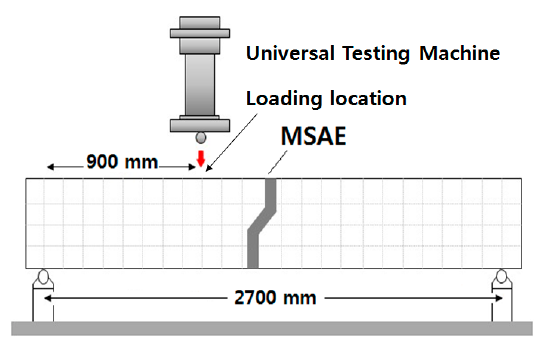
Figure 12. Eccentric 3-point loading test.